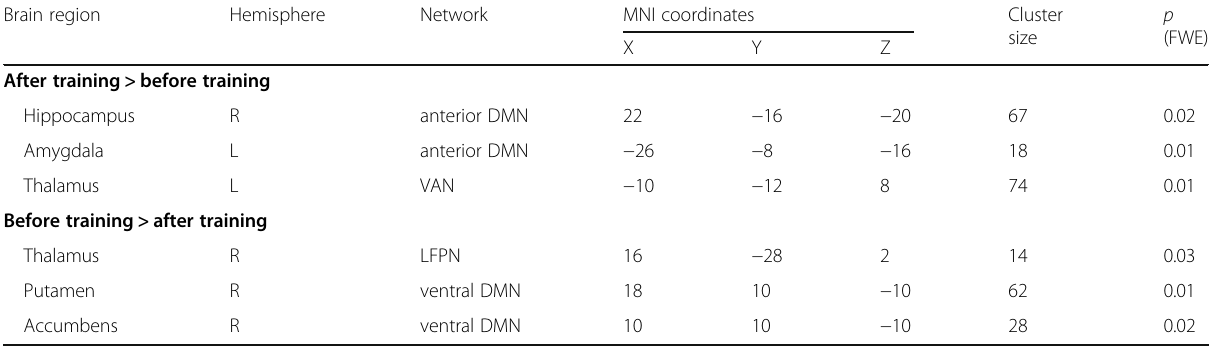
Table 5 Subcortical areas with significant changes of connectivity to different networks in functional illiterates after training Brain